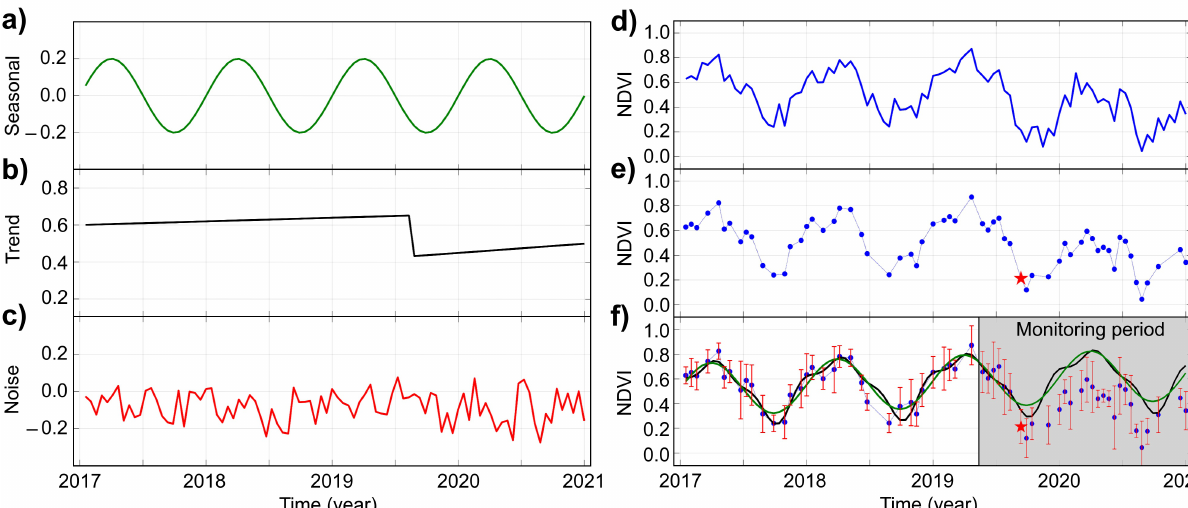
Figure 5. Simulation of a 16-day NDVI time series: ( a ) seasonal component, ( b ) trend component with an abrupt change in 2019 with a negative magnitude, ( c ) noise component, ( d ) the sum of seasonal, trend, and noise components, ( e ) 30% of the observations are randomly removed, and ( f ) illustration of near-real-time monitoring. The breakpoint or jump is shown by a red star. The red vertical bars are the error bars. The black curve is the result of an over-fitting issue that arises when the sinusoids of frequencies 1,2,3 cycles per year are forced to be fitted to the stable time series segment, so when the result is forecast into the monitoring period, shown in the gray background, the breakpoint may not be correctly